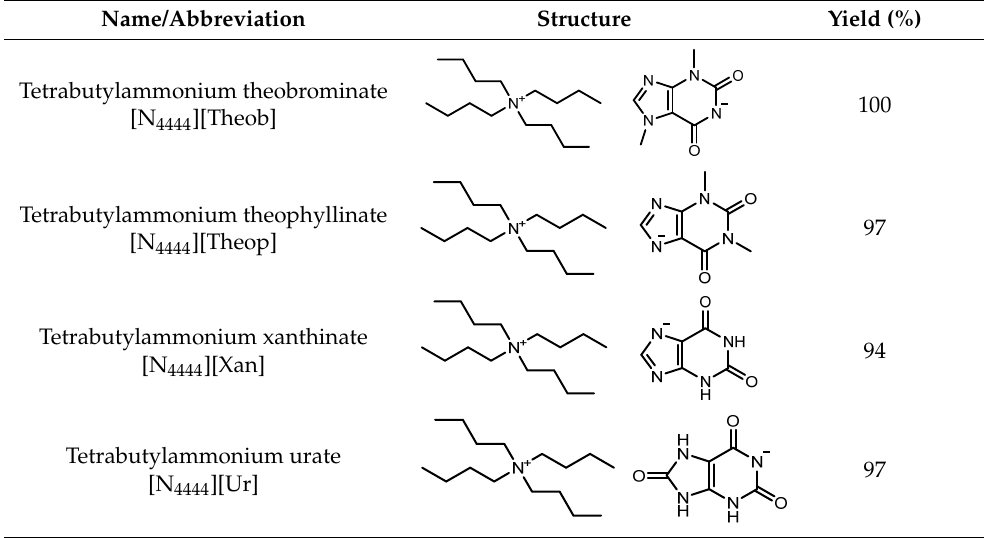
Table 1. Synthesized salts and respective names, abbreviations, chemical structures, and synthesis yields (%).